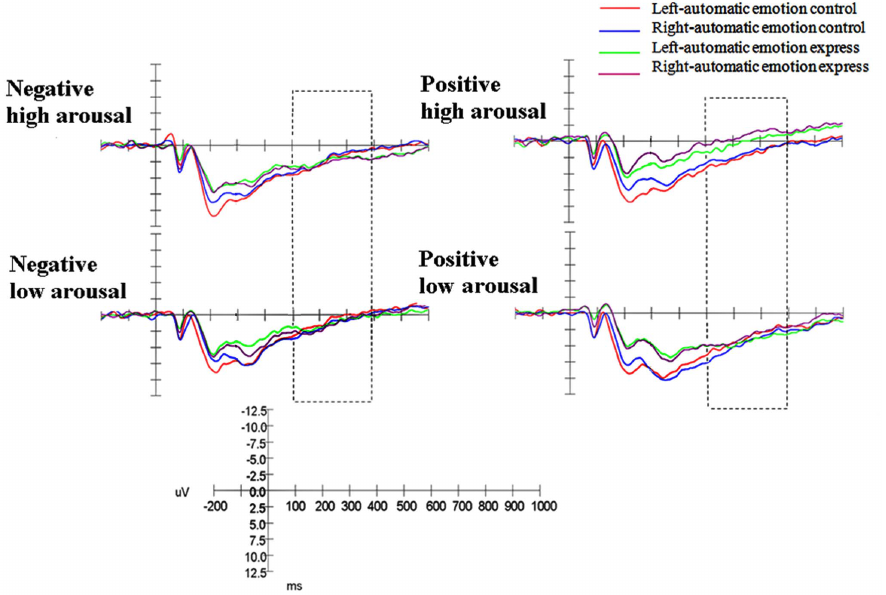
Figure 2. ERPs for automatic emotion control and automatic emotion express groups during four emotion blocks at posterior electrodes. Left=left electrodes. Right=right